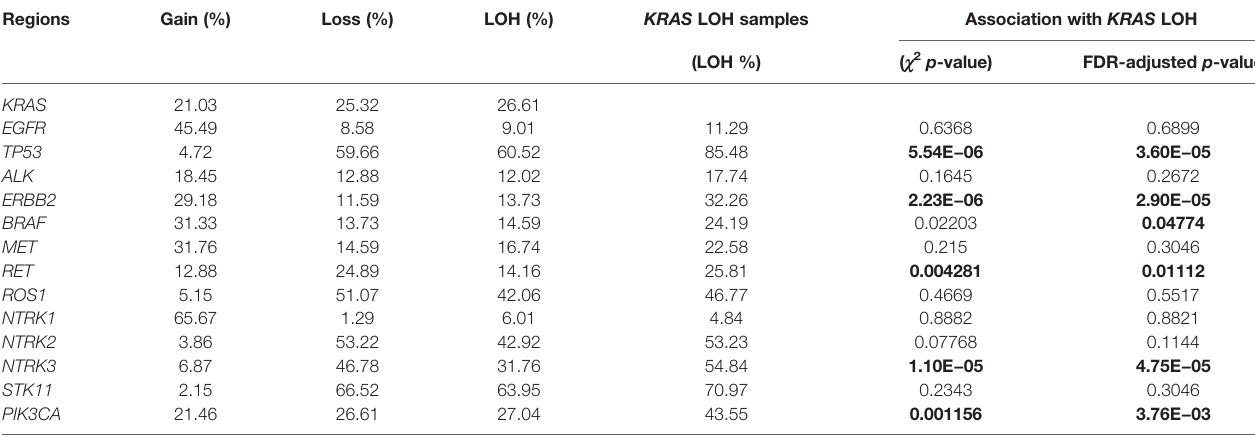
TABLE 4 | Copy number changes in common hotspots in lung adenocarcinomas and associations between LOH in genetic hotspot regions and KRAS LOH.